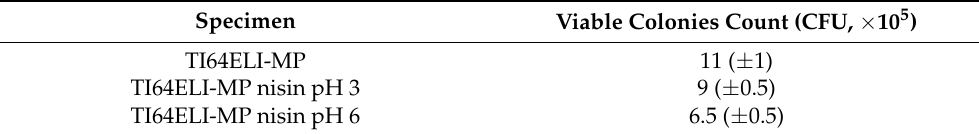
Figure 10. Antibacterial activity evaluation of Ti64ELI-MP functionalized with nisin at pH 3 and pH 6 after 24 h; ( A ) metabolic activity of bacterial cells normalized towards bare substrate Ti64ELI-MP; ( B ) SEM images at two magnifications: 2000× (scale bare = 10 µm) and 5000× (scale bar = 5 µm). Table 2. Viable bacterial colonies number (CFU count, means ± dev.st) after 24 h specimens’ direct